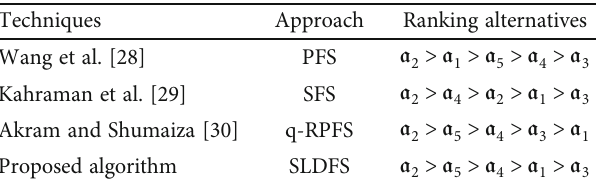
Table 12: Comparison with existing